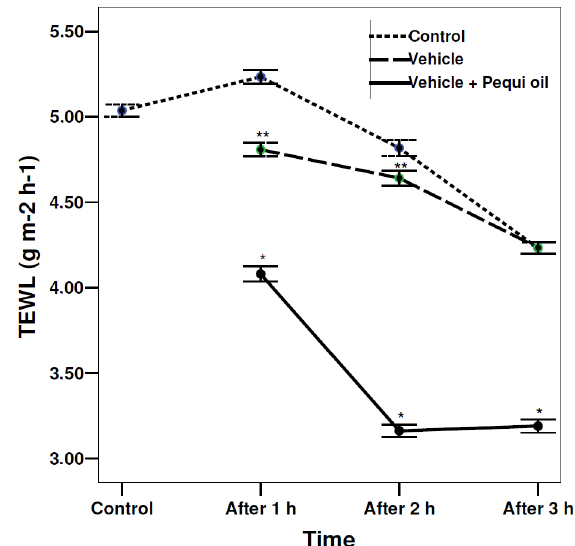
FIGURE 2 – Transepidermal water loss (TEWL) before (control – baseline values) and at 1, 2 and 3 hours after, application of the formulation under study (Control – no formulation, Vehicle, Vehicle + 10% Pequi oil). Data are expressed as means and error bars represent confidence intervals (95%). *p<0.05 vs control and vehicle. **p <0.05 vs control and vehicle + pequi